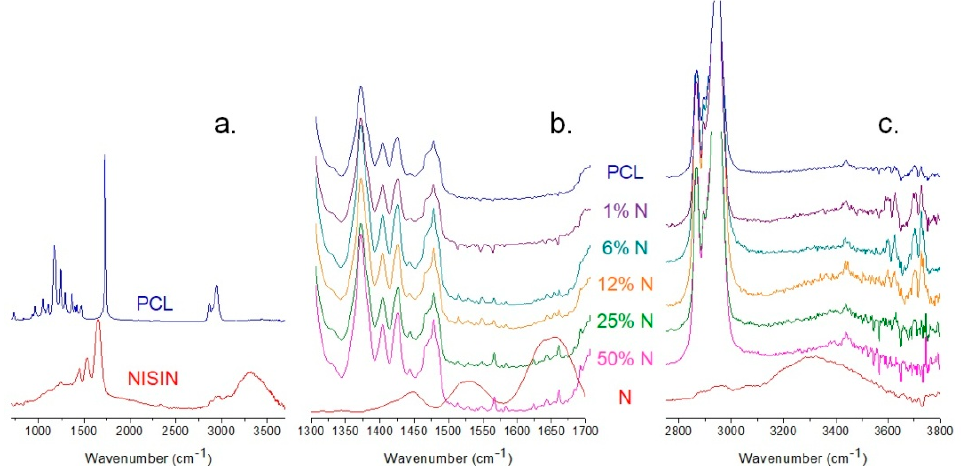
Figure 4. The infrared spectra of ( a ) plain PCL and nisin, and comparison of plain samples to the composites PCL/nisin samples in detail in regions ( b ) 1300–1700 cm − 1 and ( c ) 2750–3800 cm − 1 .